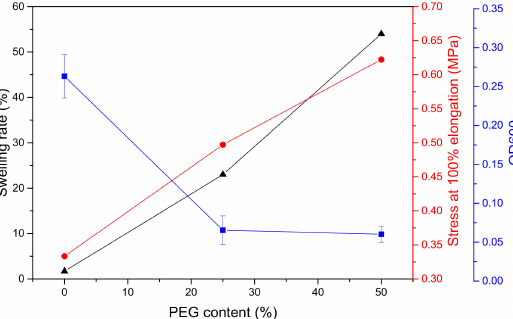
Figure 14. Bacteria attached (OD600) to the coatings, swelling rate and stress at 100% elongation with PEG